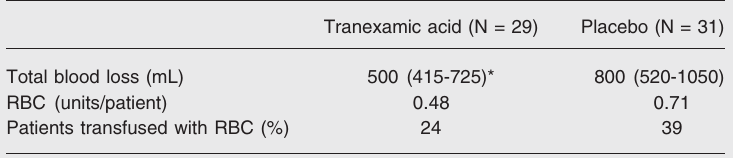
Table 2. Postoperative bleeding and transfusion